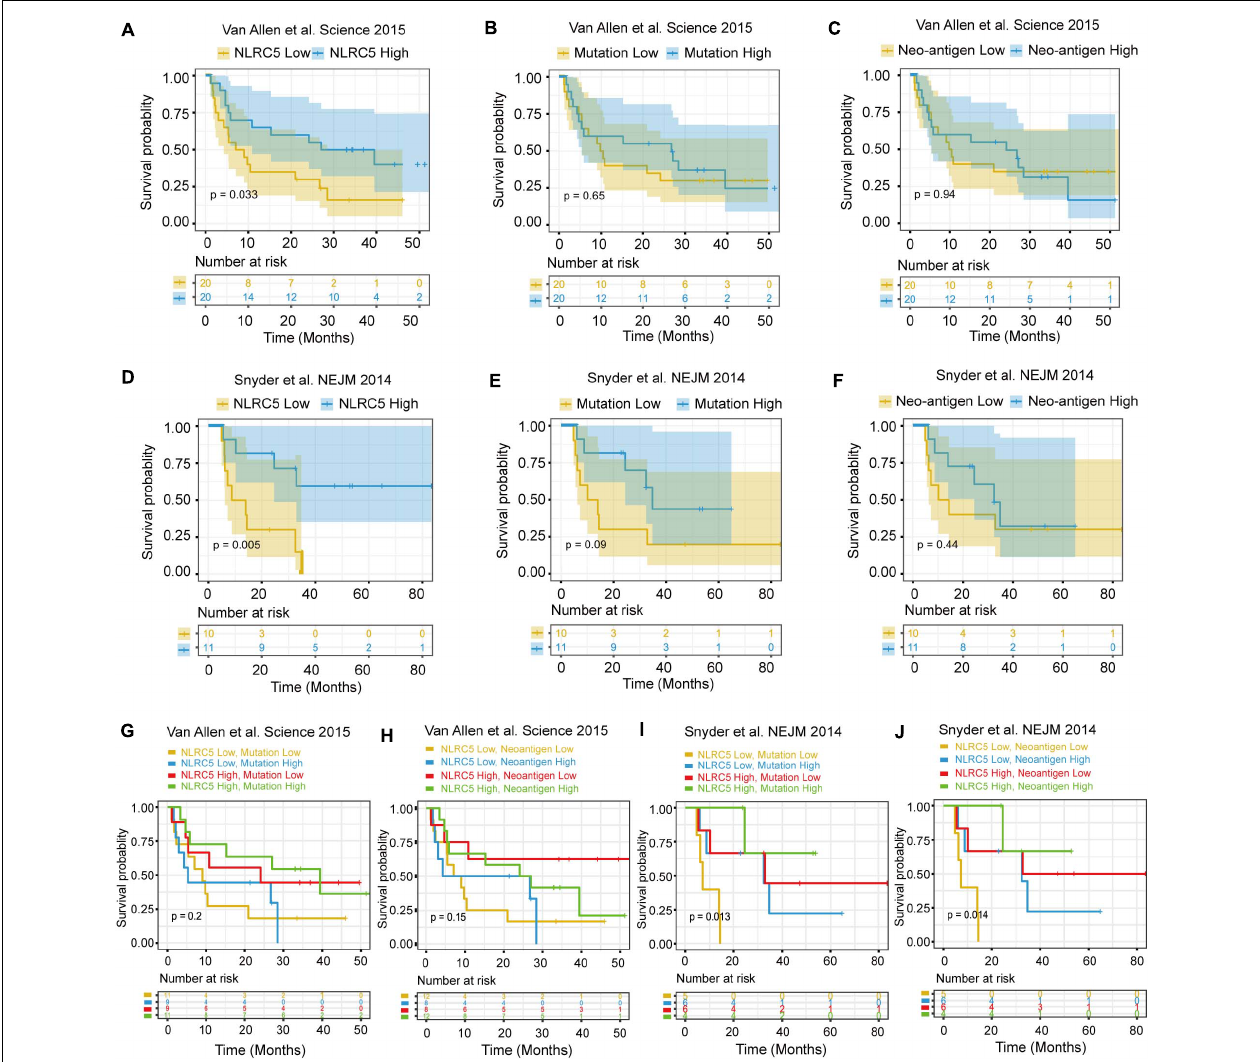
FIGURE 10 | Survival analysis of melanoma patients receiving immunotherapy. (A–C) Kaplan–Meier analysis of OS (overall survival) of patients with melanoma according to the NLRC5 expression, mutation load, and neoantigen load in the “Van Allen et al. Science 2015” dataset, respectively. (D–F) Kaplan–Meier analysis of OS (overall survival) of patients with melanoma according to the NLRC5 expression, mutation load, and neoantigen load in the “Snyder et al. NEJM 2014” dataset, respectively. (G) Kaplan–Meier analysis of OS of patients with melanoma according to both the NLRC5 expression and mutation load in the “Van Allen et al. Science 2015” dataset. The patients were stratified into four groups using the median NLRC5 expression and mutation load as a cutoff. (H) Kaplan–Meier analysis of OS of patients with melanoma according to both the NLRC5 expression and neoantigen load in the “Van Allen et al. Science 2015” dataset. The patients were stratified into four groups using the median NLRC5 expression and neoantigen load as a cutoff. (I,J) The survival analyses presented were generated as in (G) and (H) with the “Snyder et al. NEJM 2014”